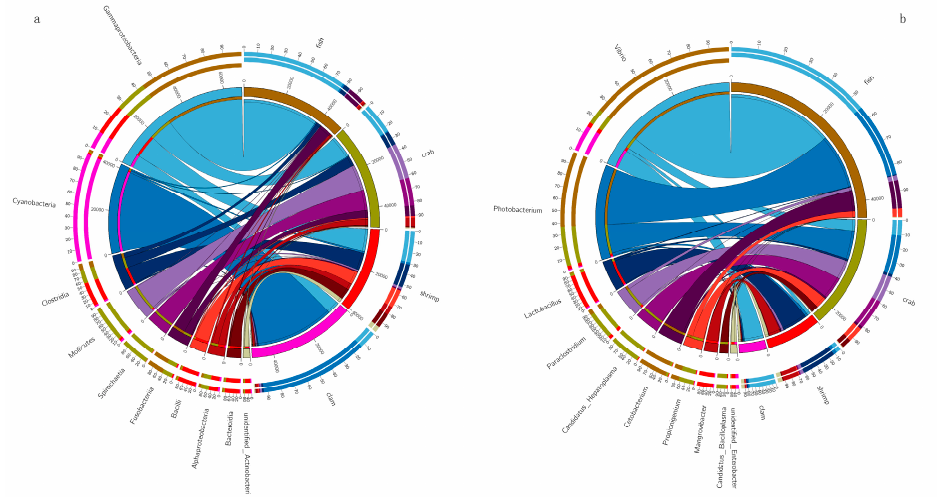
Figure 2. Dominant bacteria in the intestines of shrimp, crab, fish and razor clam, at phylum ( a ) and genus ( b ) levels.